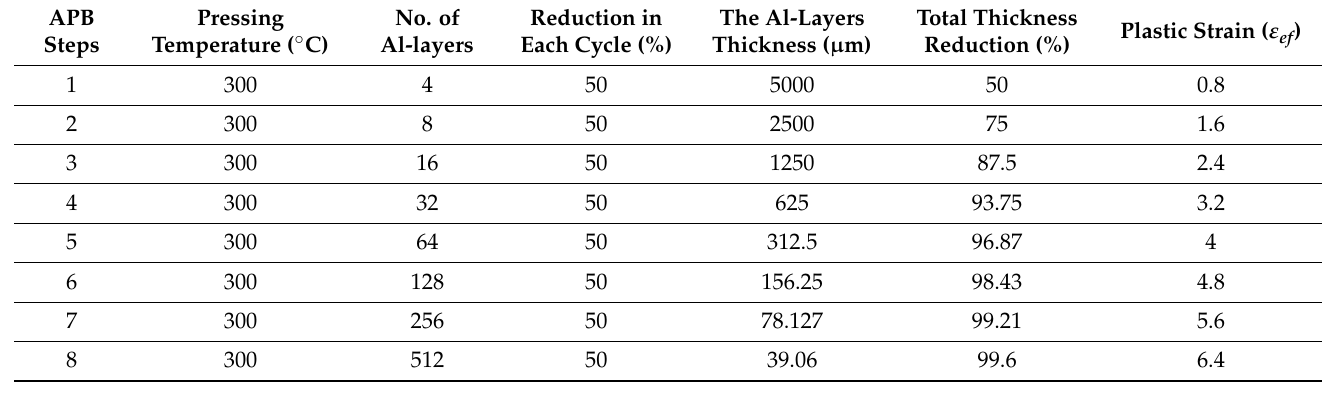
Table 2. The cumulative steps of the APB process to fabricate Al/TiC composites.